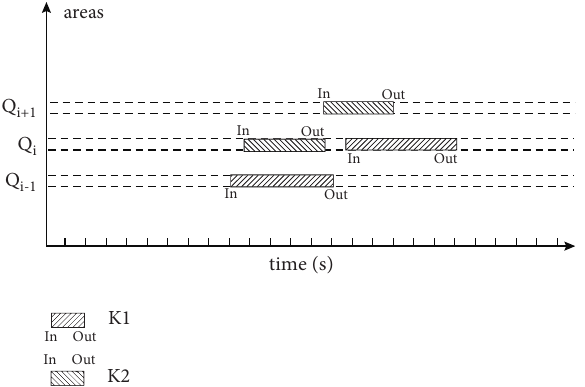
Figure 9: Update time window for cross-conflict.